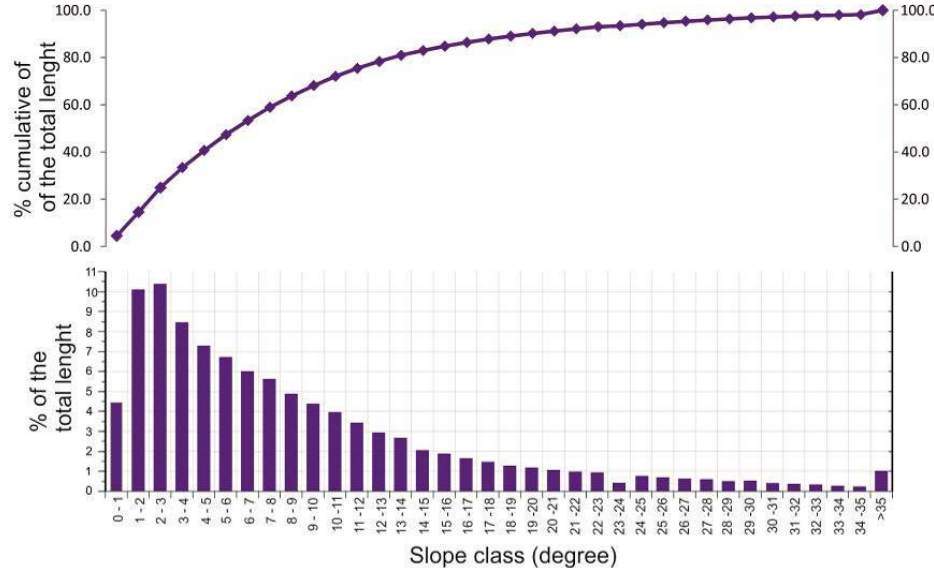
Figure 8. Frequency distribution (to the bottom) and cumulative curve (to the top) of the slope classes of the reconstructed path of the Via Herculia.